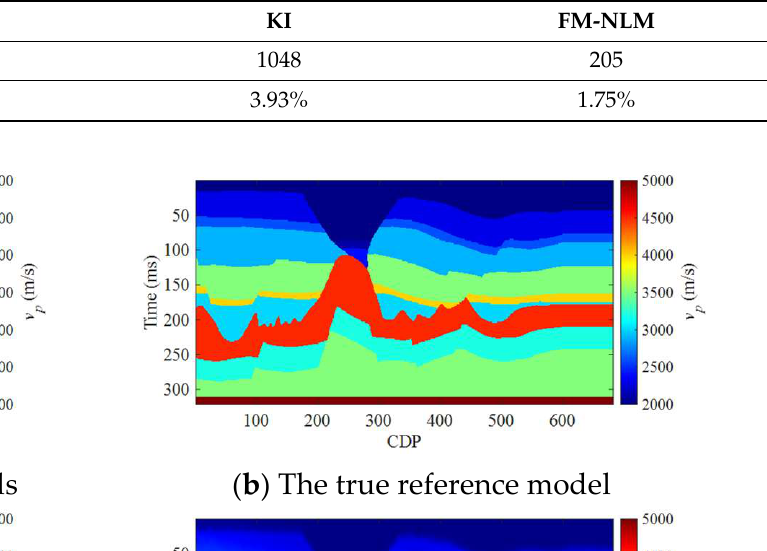
Table 1. The computational time and REs for interpolations.